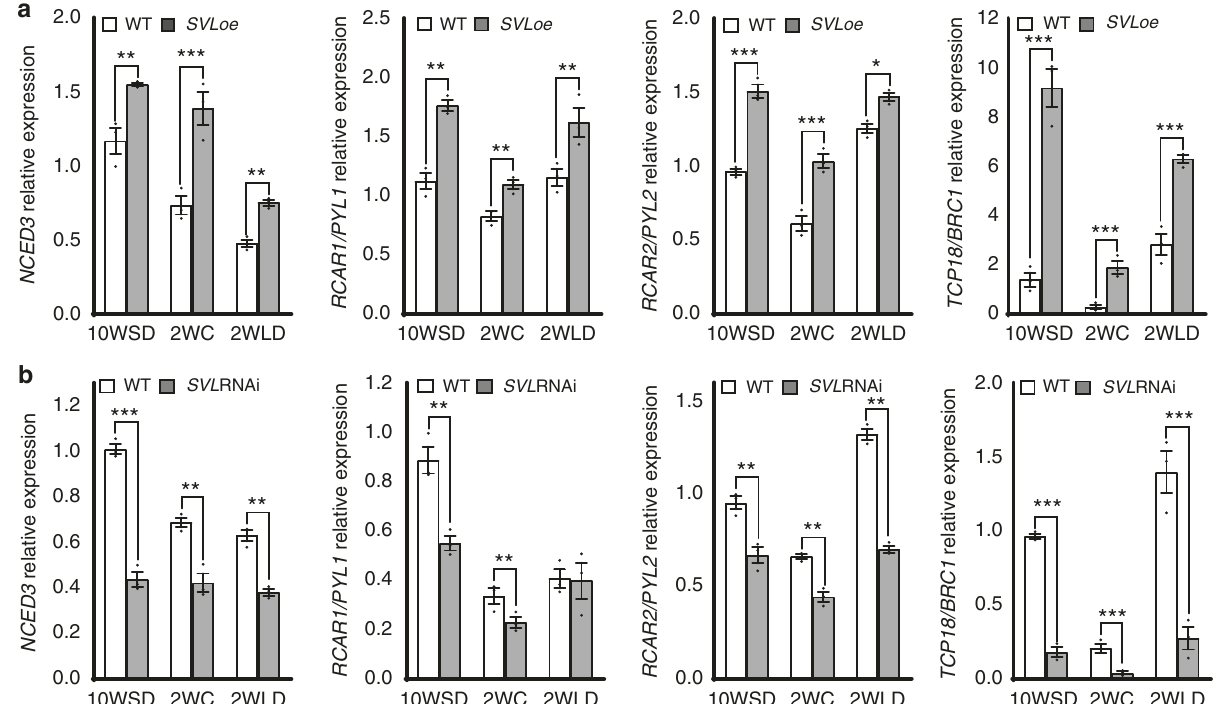
Fig. 3 SVL positively regulates expression of the ABA biosynthesis gene NCED3 , ABA receptors ( RCAR/PYLs ), and TCP18 / BRC1 -like transcription factors during dormancy release and bud break. Expression patterns of NCED3 , RCAR/PYL1 , RCAR/PYL2 , and TCP18 in apices of a WT and SVL oe and b WT and SVL RNAi after 10 weeks of SDs (10WSD), at the time of dormancy release (i.e. after 2weeks of LT, 2WC), and after 2 weeks subsequent exposure to long days and warmer temperatures (2WLD). Expression values of the cited genes shown are averages for three biological replicates ± SEM, relative to the reference gene UBQ and with 10WSD time point set to 1. Asterisks indicate signi fi cant (* P < 0.05), very signi fi cant (** P < 0.005) and extremely signi fi cant (*** P < 0.001) differences from corresponding controls, respectively. Statistical analysis was done using multiple t -test